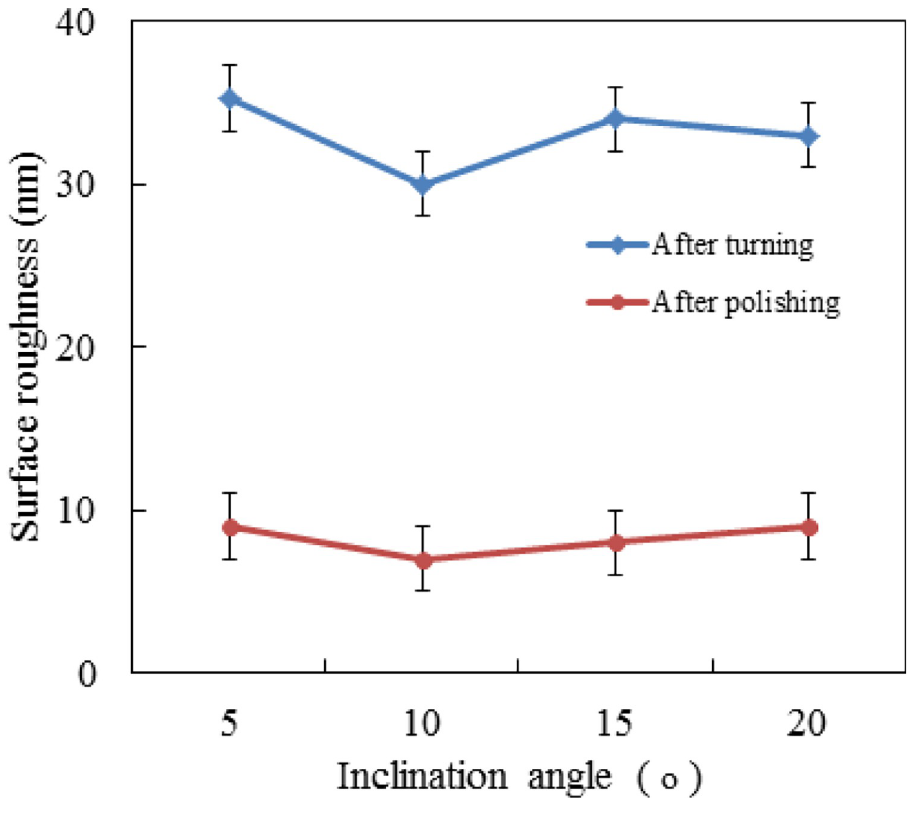
Fig 8. Effect of inclination angle on